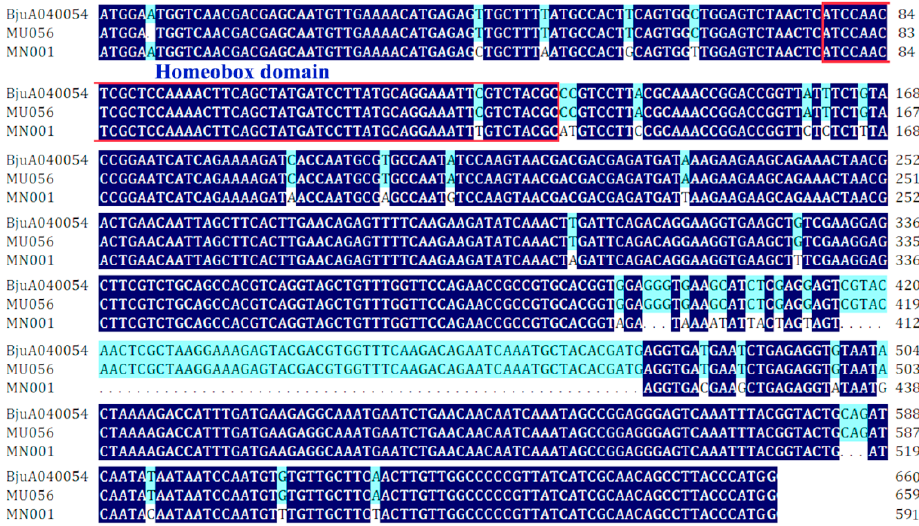
Figure 4. Comparison of candidate gene sequences between parents. Base substitutions and deletions were indicated in gray and white. The red line indicated a conserved domain.